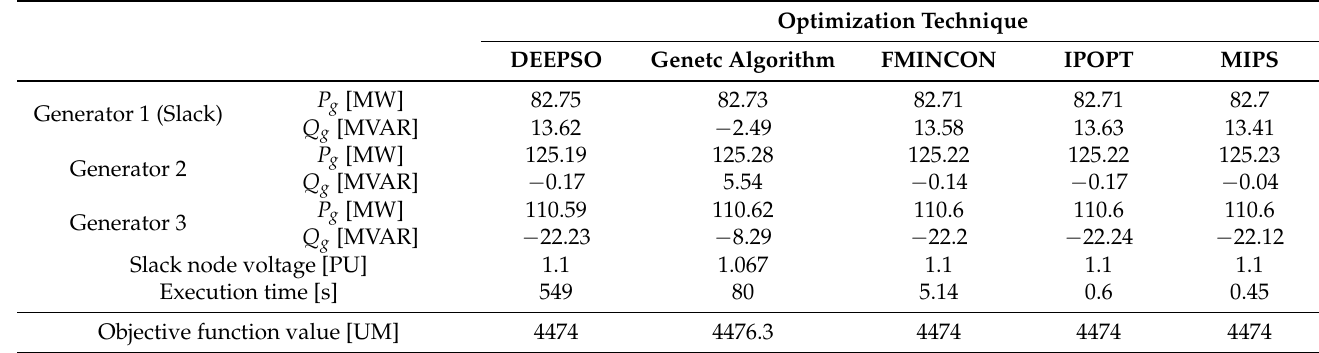
Table 6. Results obtained for the 9-node system in scenario 2.